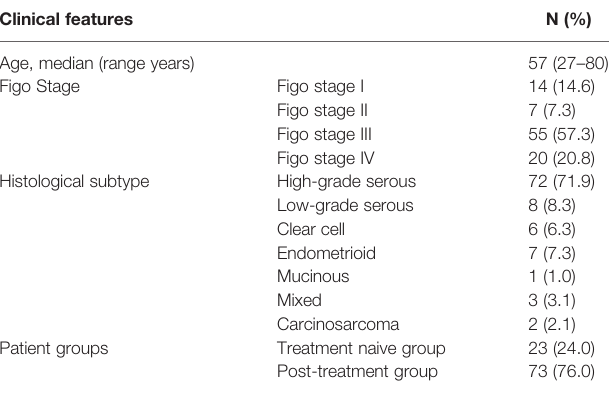
TABLE 1 | Clinical features of the 96 patients included in the study. Clinical